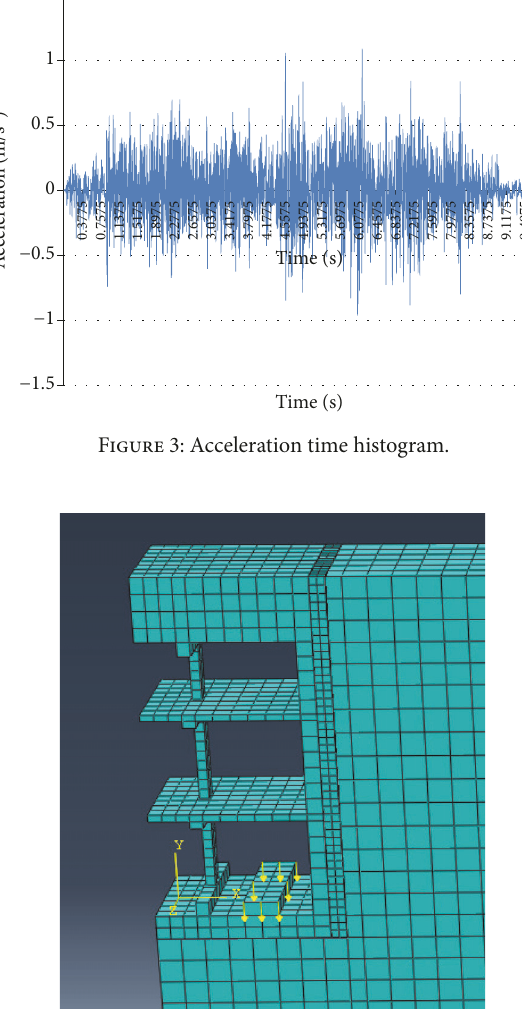
Figure 4: Details of station and location of